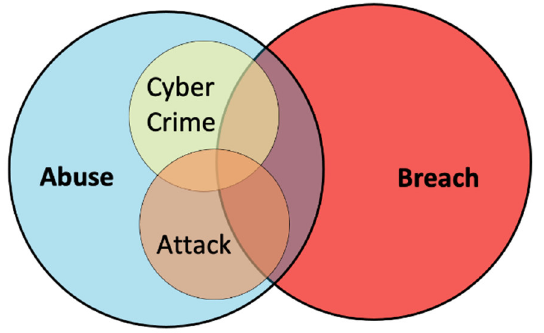
Figure 3. Relationship among abuse, attack, cybercrime and data